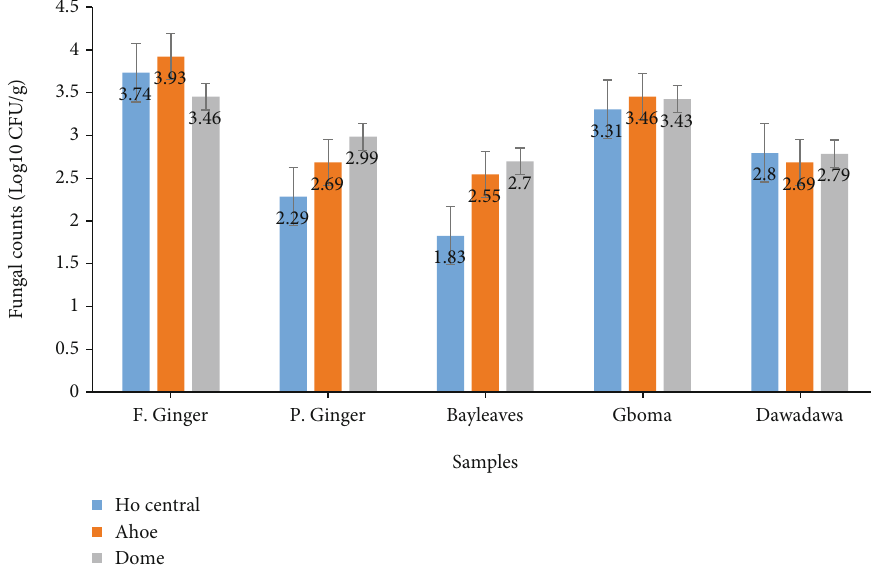
Figure 1: Mean fungal counts on samples from the three markets. Data presented are means ± standarderror